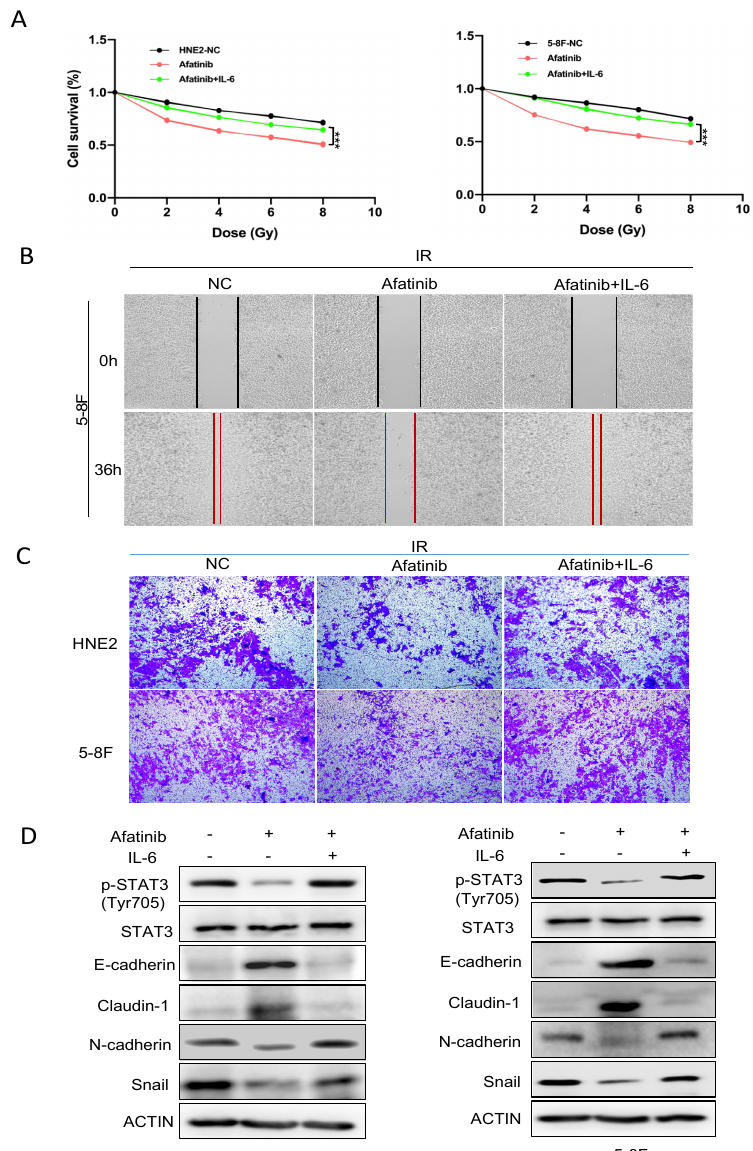
Figure 6. Stat3 agonist reversed sensitivity to IR by regulating EMT. ( A ) HNE2 cells were treated with or without IL-6 after exposure to afatinib combined IR treatment and cell viability was evaluated by CCK-8 assay. ( B , C ) HNE2 and 5-8F cells were treated with or without IL-6, cell migration was measured by wound healing assay ( B ) and transwell assay ( C ). ( D ) HNE2 and 5-8F cells were treated with IL-6 after exposure to IR, WCLs were prepared and analyzed by immunoblotting with indicated antibodies. *** denotes p < 0.001.